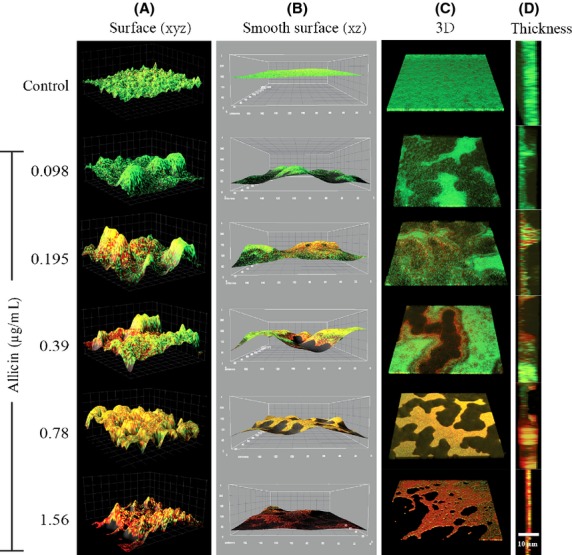
Staphylococcus epidermidis (ATCC 35984) biofilm architecture after exposure to increasing concentrations of allicin. CSLM images of S. epidermidis biofilm surface and smooth surface from (xz) (A, B); biofilm 3D and thickness images (C, D) after exposure to different allicin concentrations (0.098–1.56 μg/mL). The biofilm thickness decreased from 10.7 (controls) concentration-dependently to 8.6, 7.7, 8.0, 7.9, and 4.7 μm (1.56 μg/mL allicin) with increasing allicin concentrations. Cells were distinguished by staining total bacterial cells with SYTO® green (green) and nonviable bacterial cells with propidium iodide (red).